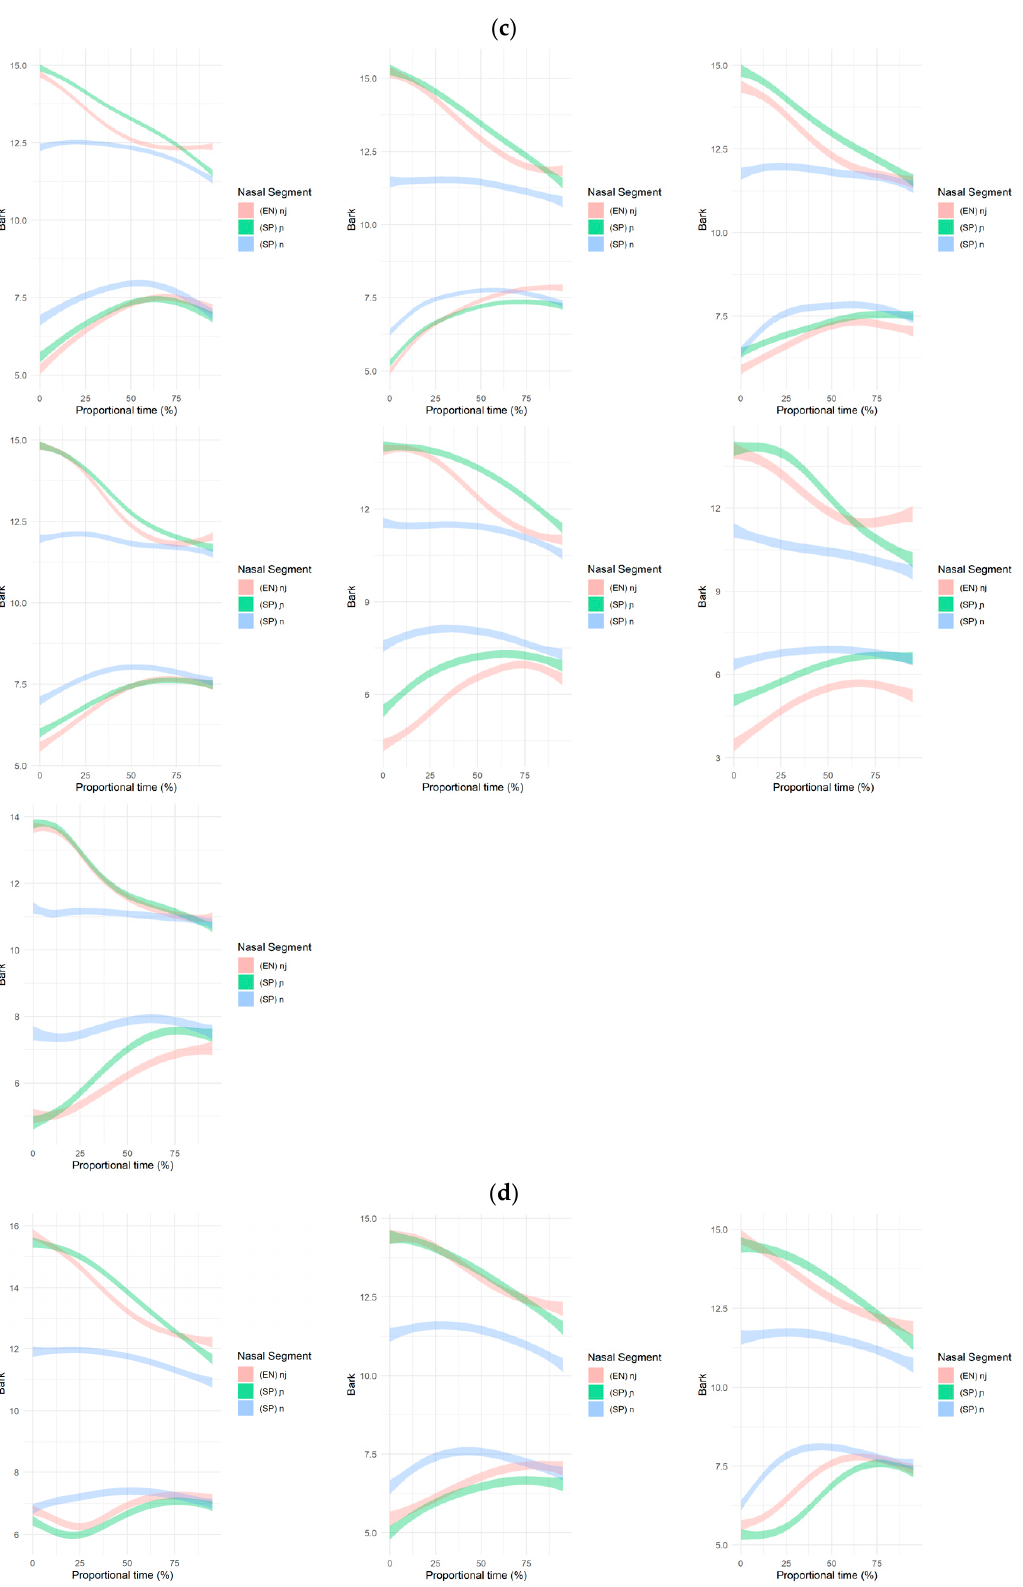
Figure A1. ( a ) Pattern 1: individual splines that follow the group pattern. ( b ) Pattern 2: individual splines that differ in F1 from the group pattern. ( c ) Pattern 3: individual splines that differ in F2 from the group pattern. ( d ) Pattern 4: individual splines that differ in F1 and F2 from the group pattern.